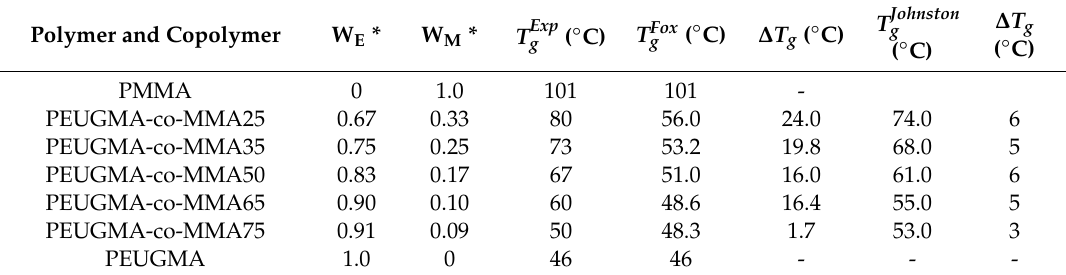
Figure 13. Di ff erential scanning calorimetry (DSC) and derivative-DSC thermograms of PMMA, Figure 13. Differential scanning calorimetry (DSC) and derivative-DSC thermograms of PMMA, PEUGMA and PEUGMA-co-MMA with di ff erent EUGMA content. PEUGMA and PEUGMA-co-MMA with different EUGMA content. Table 5. Experimental and calculated glass transition temperatures of PMMA, PEUGMA and